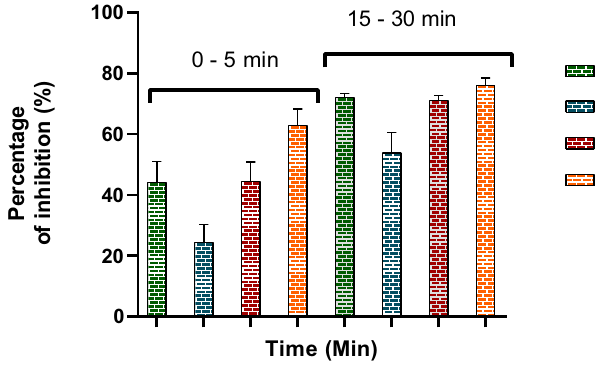
Figure 5: Percentage of pain inhibition. The values are expressed as mean ± SD ( n = 5 ) .